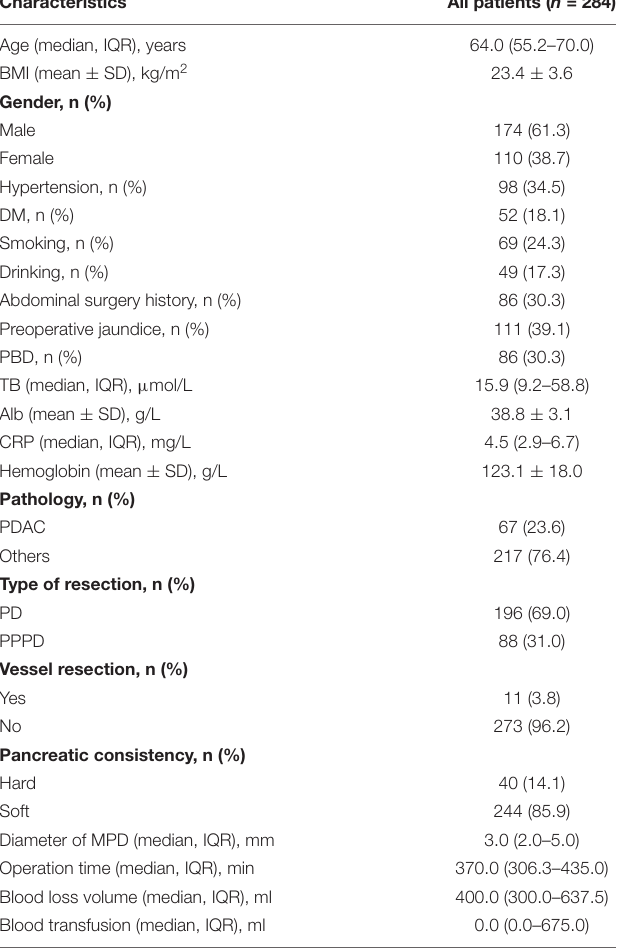
TABLE 1 | Patients characteristics. Characteristics